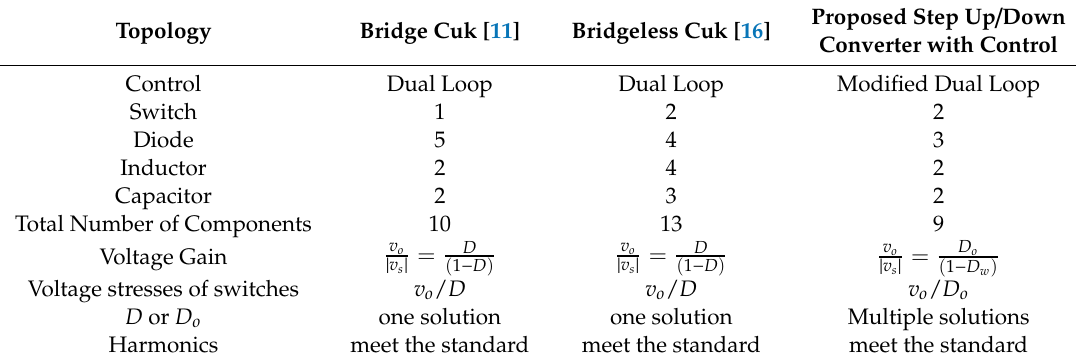
Table 1. Comparisons of step up / down converters.